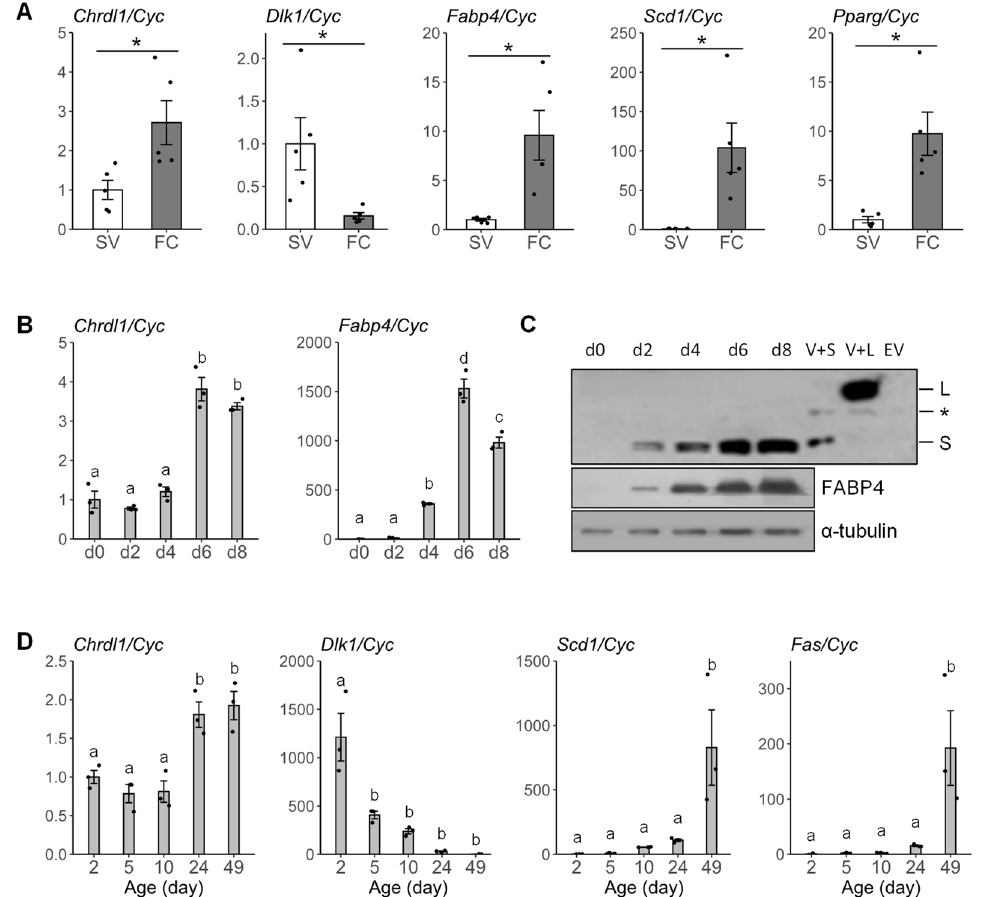
Figure 3. Fat cell-enriched expression of Chrdl1 , and developmental regulation of Chrdl1 expression in 3T3-L1 cells and mouse white adipose tissue. ( A ) Relative Chrdl1 mRNA expression in stromal vascular (SV) and fat cell (FC) fractions from mouse adipose tissue quantified by real-time PCR. Dlk1 was used a marker for SV enrichment, whereas Fabp4 , Scd1 , and Ppar γ were markers for FC enrichment. ( B ) Relative Chrdl1 mRNA expression during adipogenic differentiation of 3T3-L1 preadipocytes [day (d) 0 to 8] quantified by real-time PCR. Fabp4 was used as a marker of adipogenesis. ( C ) Representative western blot of CHRDL1 protein expression during adipogenic differentiation of 3T3-L1 preadipocytes in vitro. The experiment was performed in duplicate. The FABP4 protein was used as a marker for adipogenic differentiation. Coomassie staining and α -tubulin were used as loading controls. V+S, recombinant vector carrying CHRDL1 short-form protein (CHRDL1 S); V+L, recombinant vector carrying CHRDL1 long-form protein (CHRDL1 L); EV, empty-vector control; *, non-specific band. ( D ) Relative Chrdl1 mRNA expression during development of iWAT in vivo (in 2-day to 49-day-old mice) quantified by real-time PCR. Dlk1 was used as a negative marker of adipose development, while Scd1 and Fas were positive markers of adipose development. The Cyc gene was used as a reference gene. Values represent quadruplicate means ± SEM. *, p < 0.05. Different